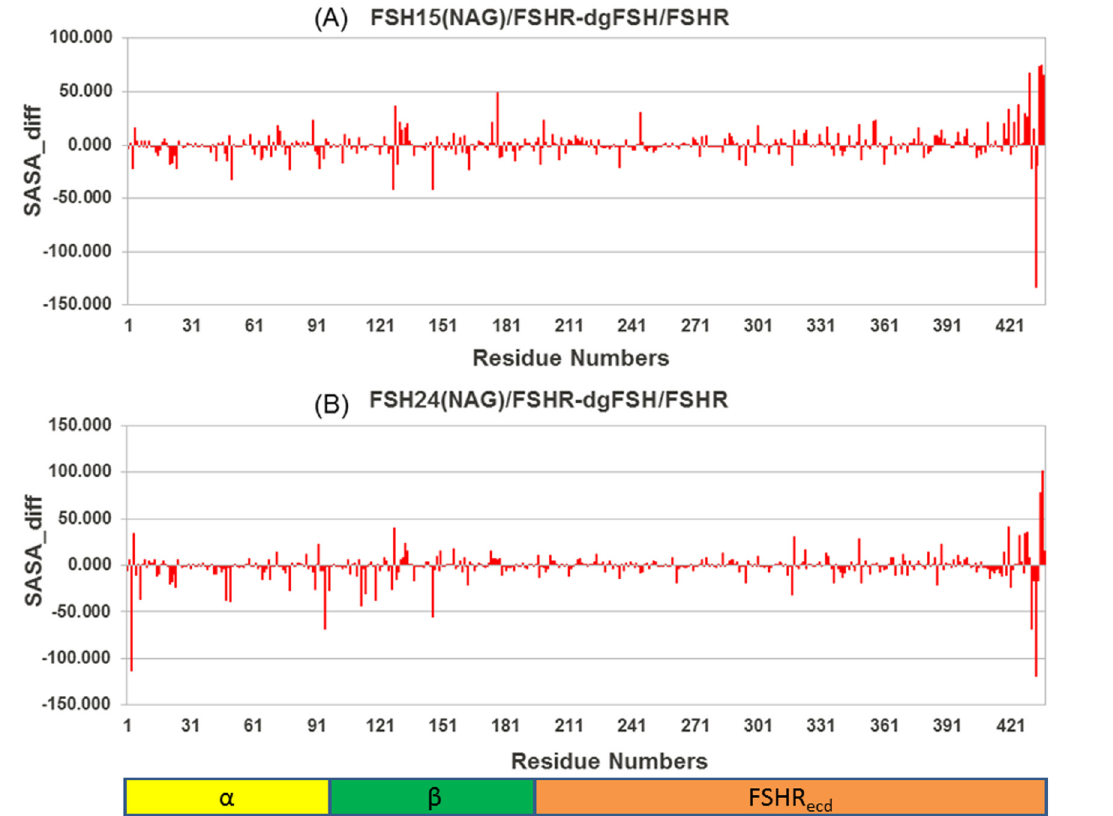
Fig 13. Difference in Solvent Accessible Surface Area (SASA) for FSH 15 (NAG)-FSHR and FSH 24 (NAG)-FSHR from dgFSH.